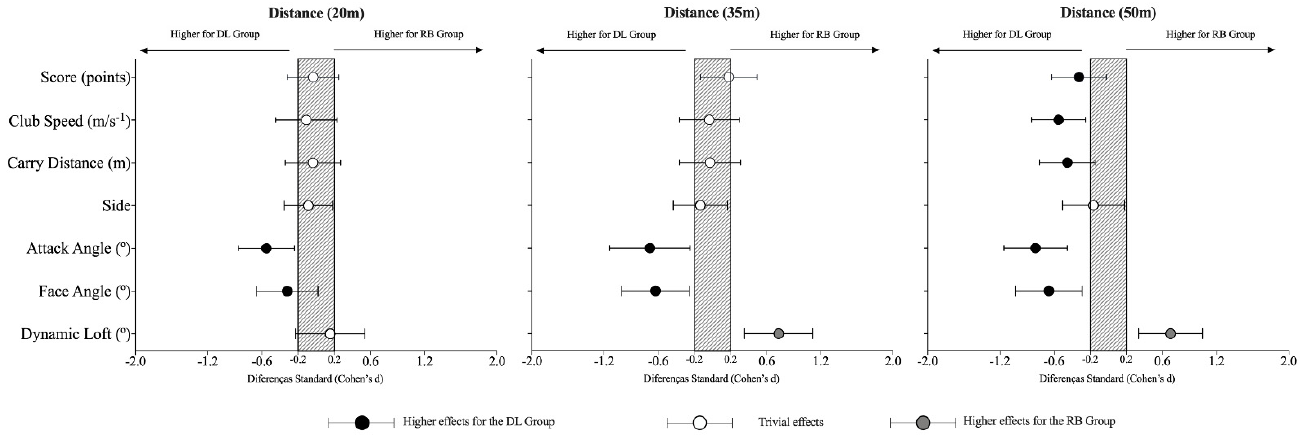
Table 4. Descriptive (M ± SD; Raw; ±95% CI) and inferential results for the golf shot performance differentiated by the low and high handicap group within the DL group.